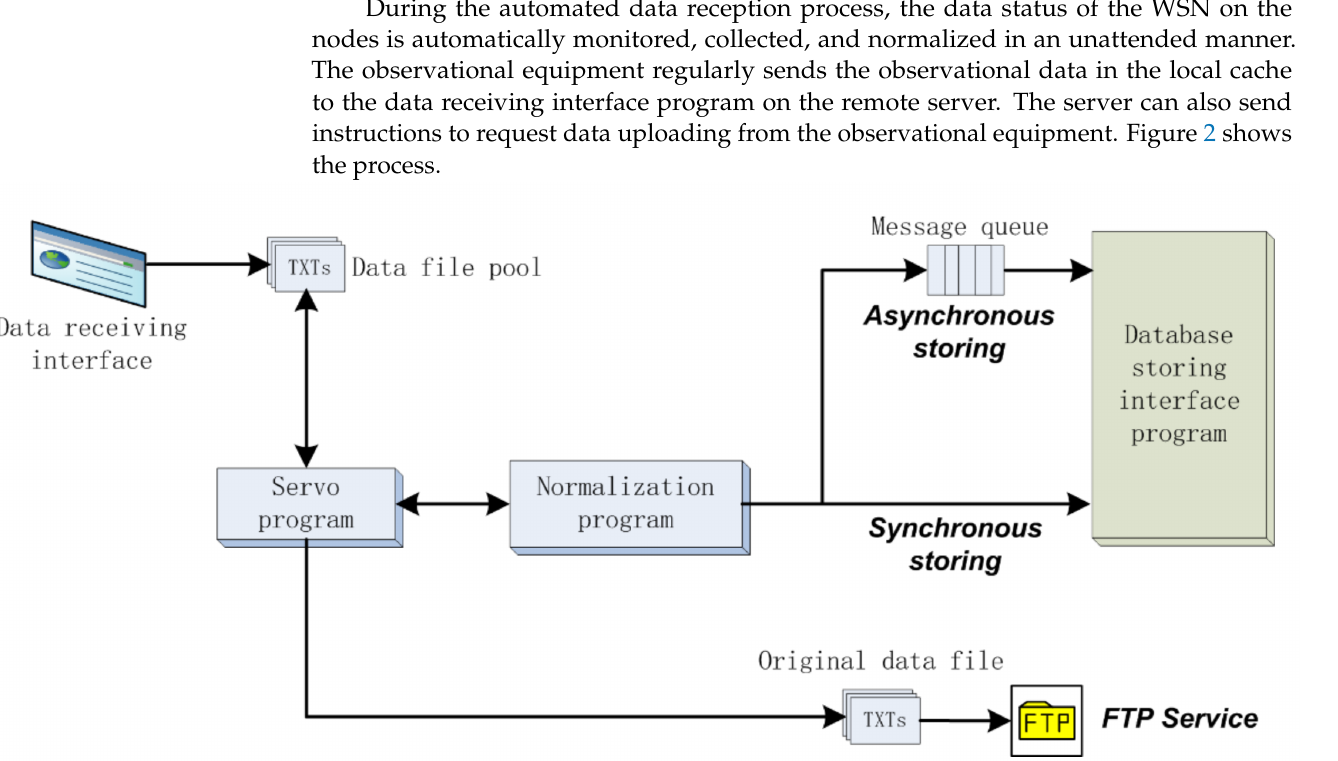
Figure 2. Process of the automatic receiving, normalizing, and storing of observational data in the